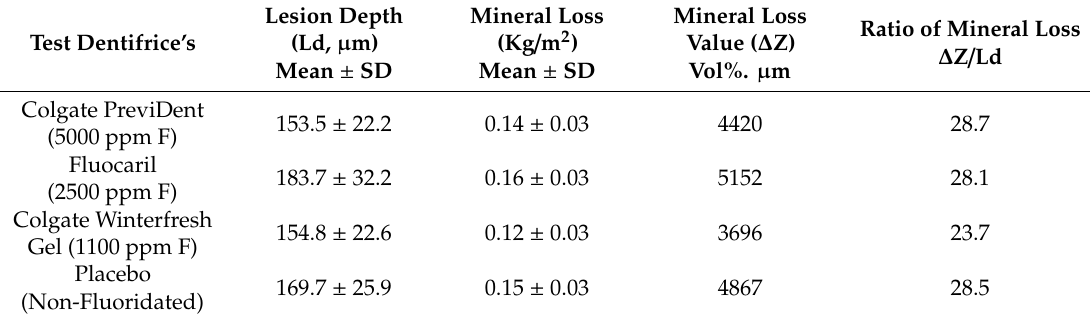
Table 3. Transversal microradiography data of dentine.